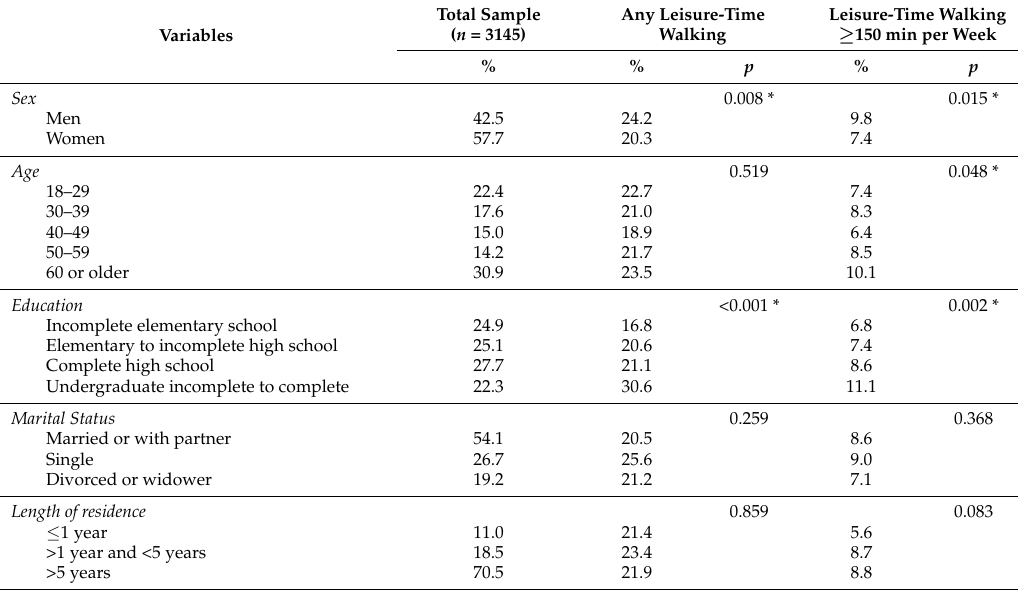
Table 1. Descriptive statistics of general sample and for participants that reported leisure-time walking, Sao Paulo,